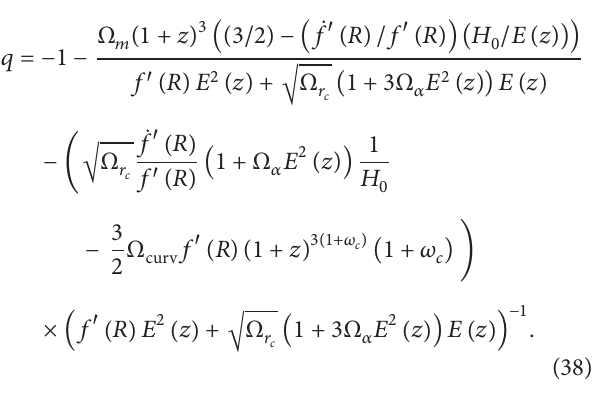
̇𝐻 Figure 5: In this model, is always negative, and, therefore, there is no superacceleration or big-rip